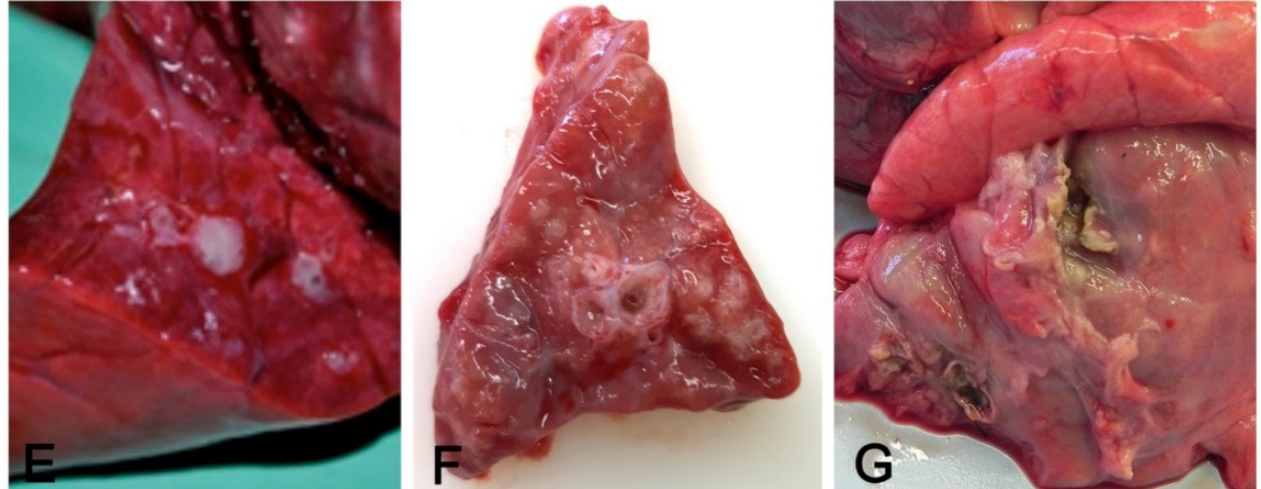
Figure 2. Aerogenous lung involvement. Cranioventral distribution ( A ) of coalescing, slightly depressed dark-red lobules ( C ) with consolidation and mucus in airways ( E ) in an acute, moderate, aerogenous non-complicated pneumonia. These features are indicative of enzootic pneumonia. Cranioventral distribution of consolidated dark-red lung parenchyma ( B ) with multifocal yellowish foci of suppuration ( D ) with pleural ulceration and fibrosis ( G ). These features are indicative of complicated enzootic pneumonia or of bronchopneumonia. In ( F ), cuffing of small airways, usually present in enzootic pneumonia, but also found in complicated pneumonias.